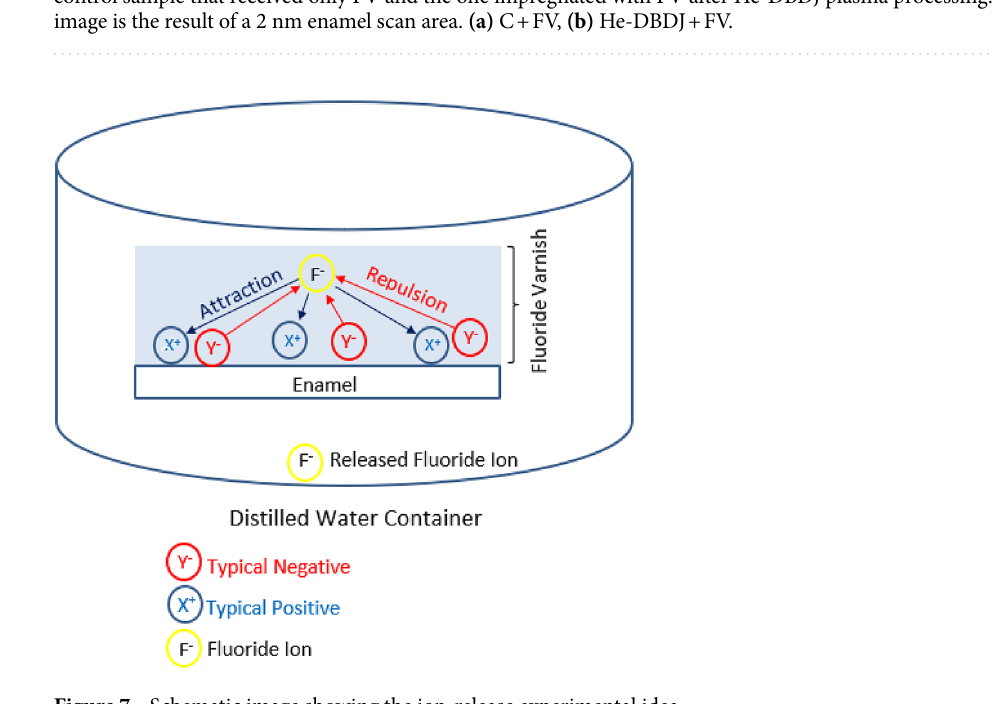
Figure 7. Schematic image showing the ion-release experimental